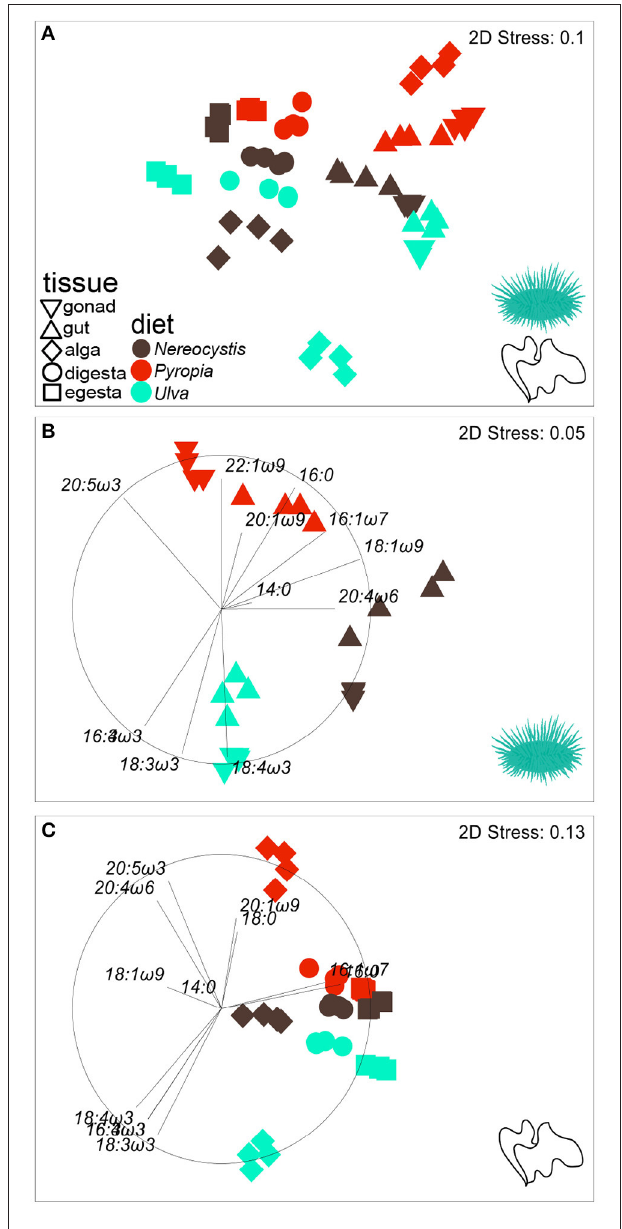
FIGURE 3 | nMDS plot (Euclidean distance) showing the proportions of FA ( n = 37) in tissues from S. droebachiensis fed monoculture diets of Nereocystis, Pyropia, or Ulva .Tissues from the feeding assay at FHL (A) are included along with subsets representing (B) urchin tissues and (C) macroalgal tissues. Vectors indicate the top five FAs identified by SIMPER analyses that distinguish FA profiles between tissues and diets ( Tables 3–5 , Supplementary Tables 7–11) and are included to visualize how FAs contribute to the relative distributions of (B) urchin and (C) macroalgal